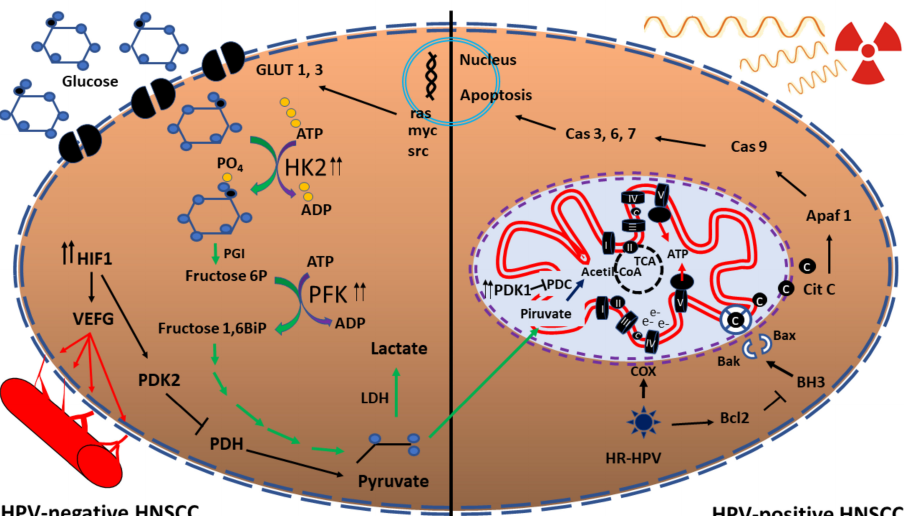
Figure 2. Metabolic reprogramming in HNSCC in response to IR. Activation of glycolysis and HIF1 in HPV-negative HNSCC cells induce radioresistance, in comparison to radiosensitive HPV-positive HNSCC cells, where OXPHOS is activated increasing ROS production and OS. In the presences of HPV, COX augments, activating the electron transport chain. Glucose transporter (GLUT), hexokinase (HK), phosphoglucose isomerase (PGI) phosphofructokinase (PFK), hypoxia-inducible factor (HIF), vascular endothelial growth factor (VEFG), pyruvate dehydrogenase kinase (PDK), pyruvate dehydrogenase (PDH), pyruvate dehydrogenase complex (PDC), cytochrome c oxidase (COX), tricarboxylic acid (TCA) cycle, cytochrome (cit), apoptosis protease-activating factor (Apaf), caspase (Cas), lactate dehydrogenase (LDH). The double arrow represents